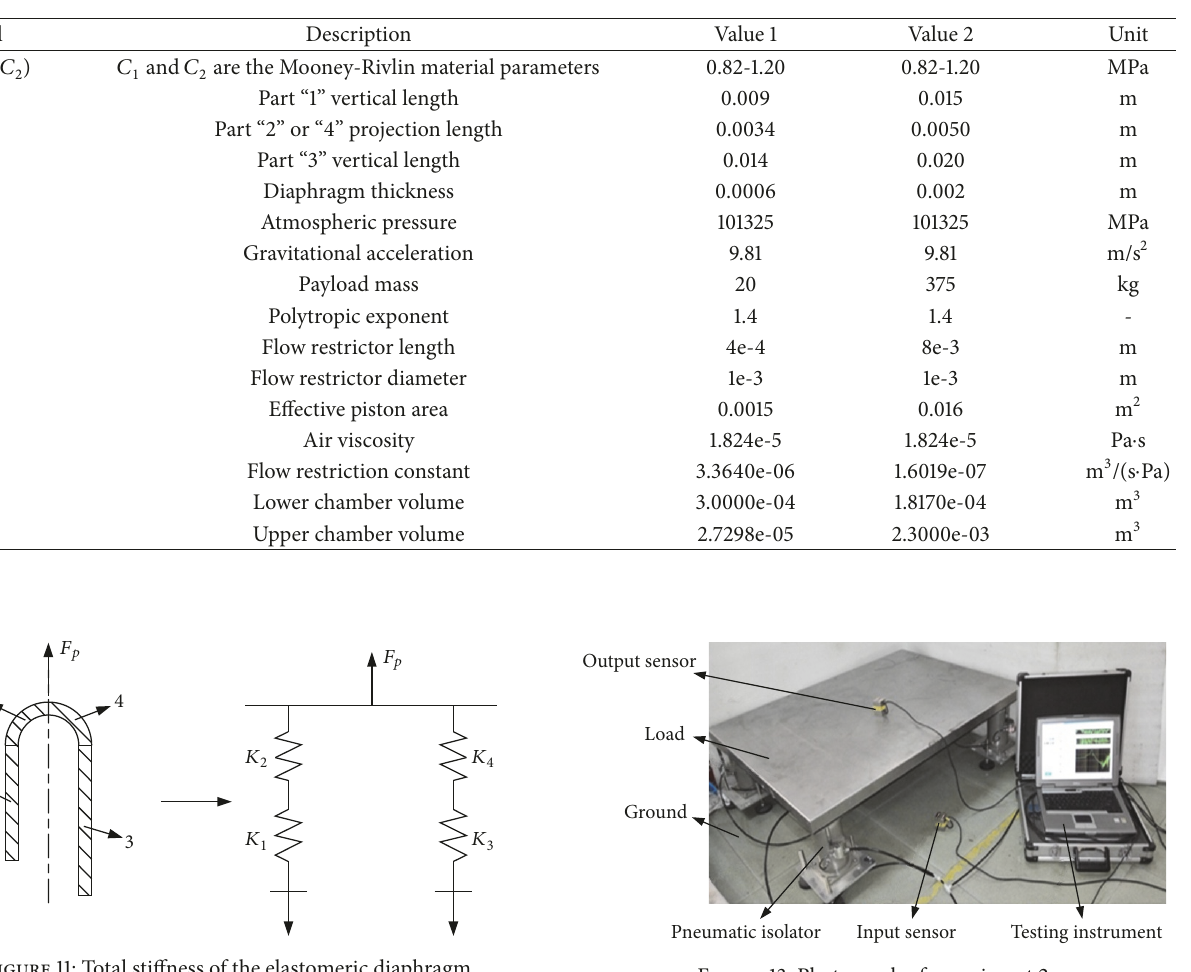
Figure 13: Photograph of experiment